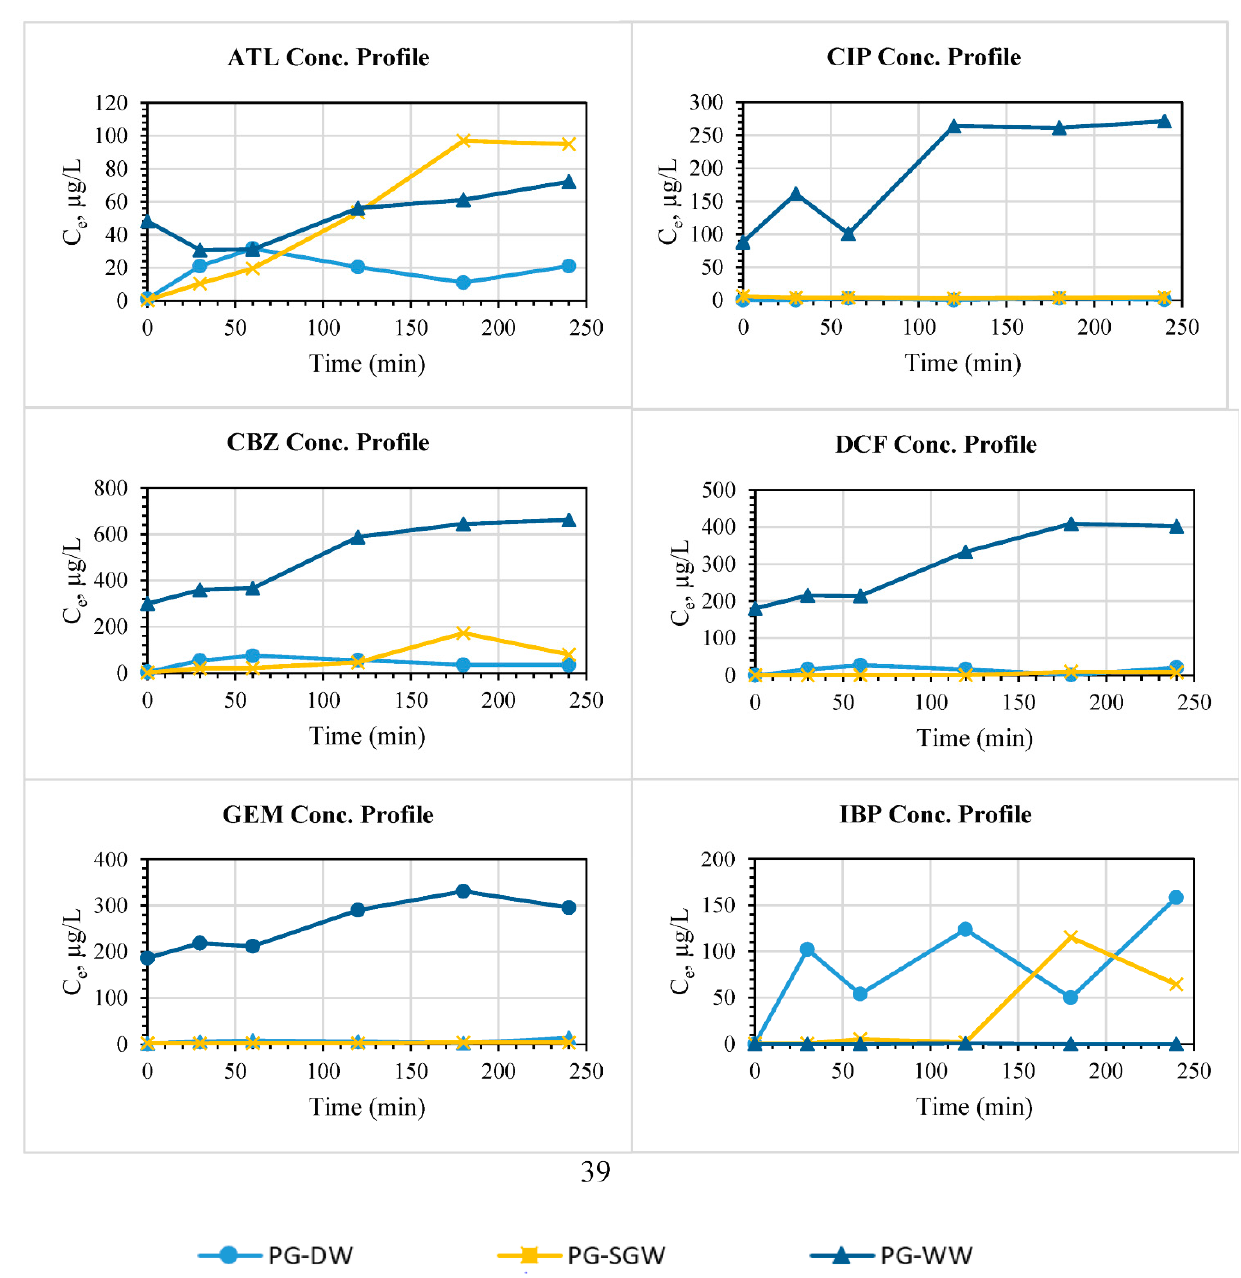
Figure 8. The breakthrough curve of EC adsorption onto PG in DW, SGW, and WW as backgrounds (pH 7.5; initial individual EC concentration: 1 mg/L; PG loading dosage: 100 mg).